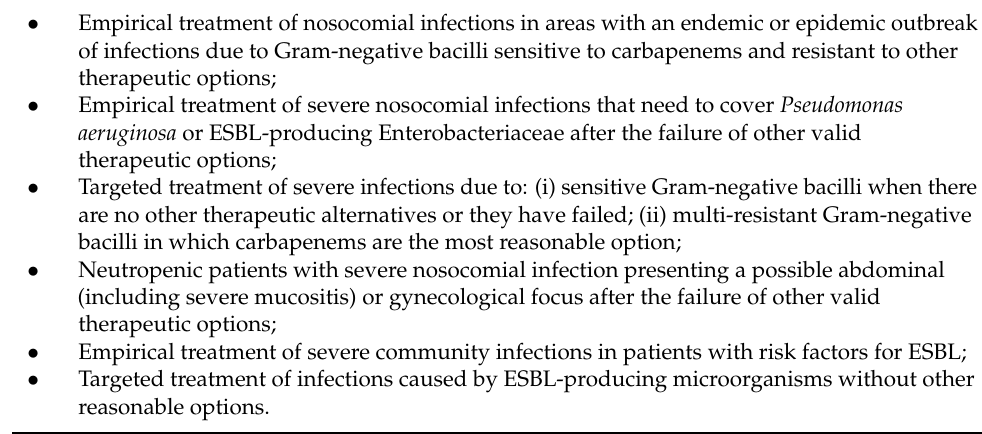
Table 5. Institutionally approved guidelines for carbapenem